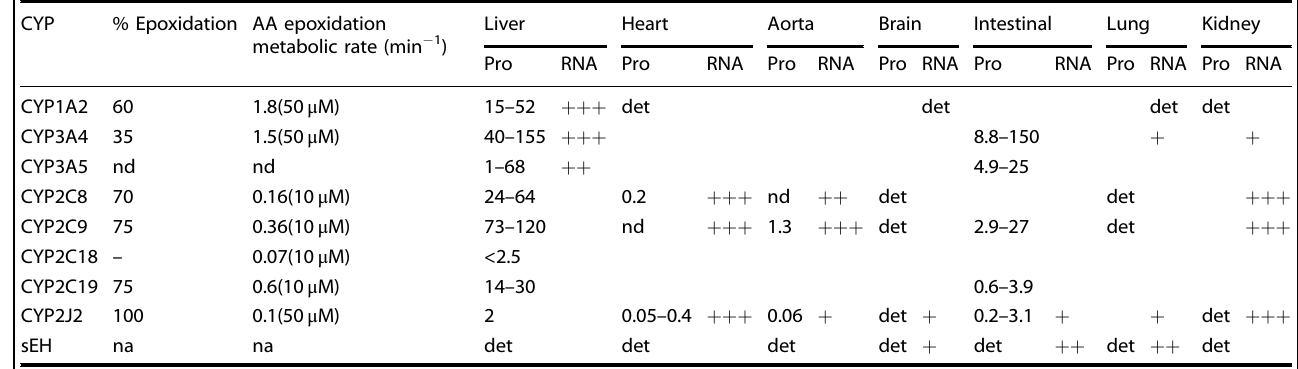
Table 1. Relevant human CYP epoxygenases contributing to the formation of EETs and their distribution